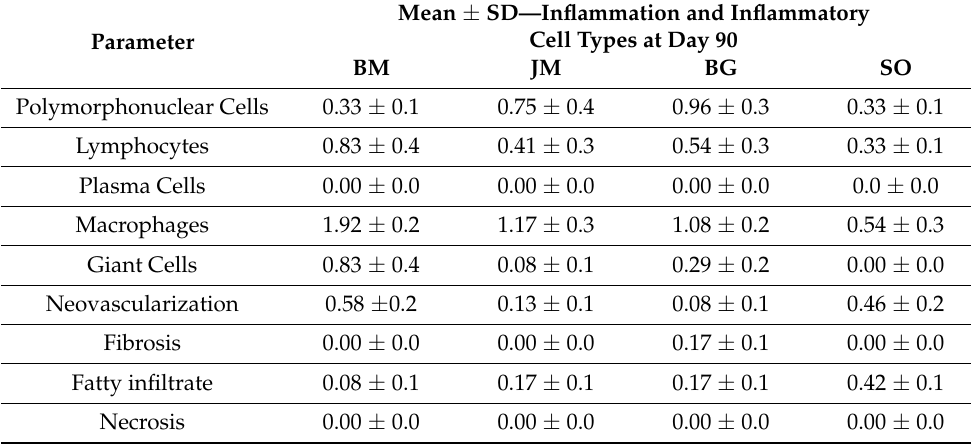
Table 7. Results of the biomaterial scoring evaluation at 90 days post implantationem. BM: bovine- based membrane, BG: Bio-Gide ® membrane, JM: Jason ® membrane, and SO: sham operation.